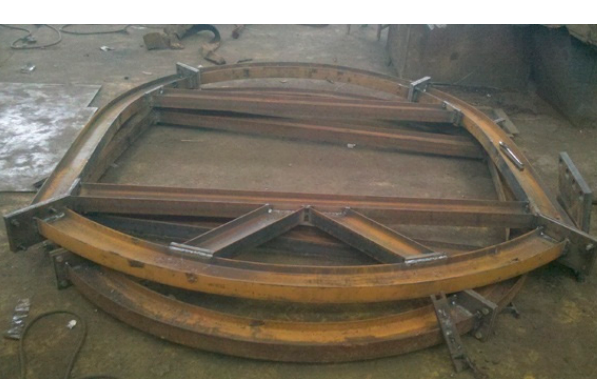
Figure 4. Uncompleted roof + floor beams + braces scaled set.